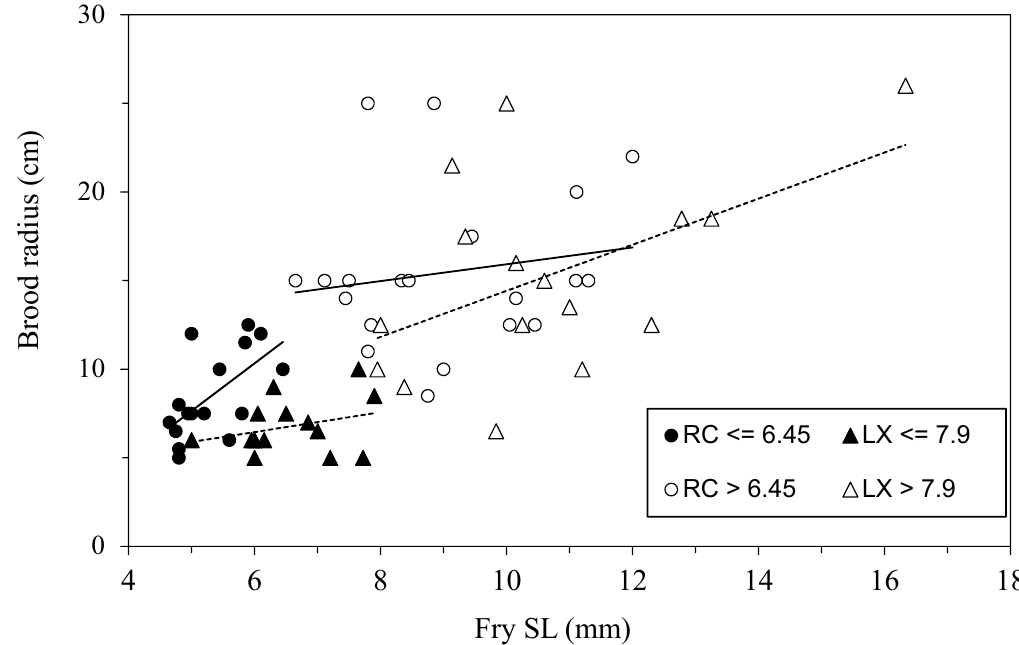
Figure 13. The radius of broods being guarded in Río Cabuyo (circles) and Laguna de Xiloá (triangles) from time of early emergence from the spawning lair to the point of independence from parental care. Change-point analysis revealed nonlinearity occurred at SL = 6.45 in Río Cabuyo fish and SL = 7.9 for fish in Laguna de Xiloá. These switch points coincide with changes in skeletal ossification or the young, ontogenetic shifts in swimming performance and changes in parental adoption behavior. Data from [21].